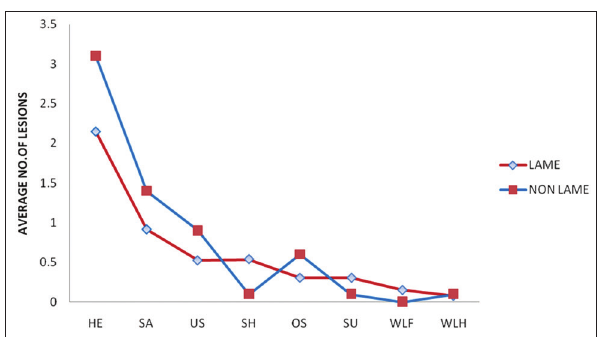
Figure-5: Comparison of average number of lesions in lame and non-lame healthy crossbred cows. (HE: Heel erosions; SA: Sole avulsions; US: Under-run soles; SH: Sole hemorrhages; OS: Overgrown soles; SU: Sole ulcers; WLF: White line fissures; WLH: White line